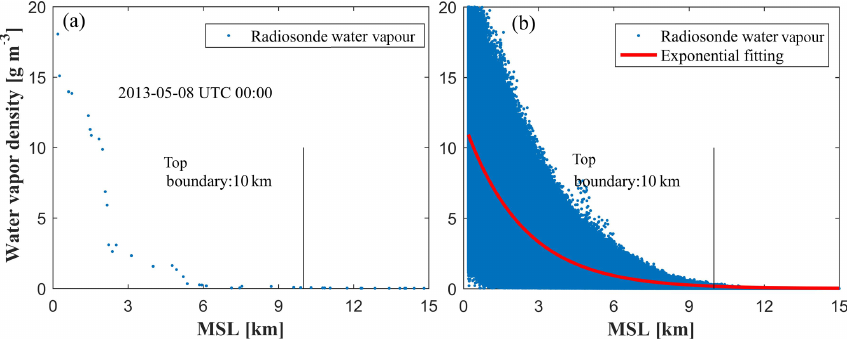
Figure 5. The vertical distribution of water vapour density in a single sounding event (a) and the 3-D water vapour distribution of the tomography area and exponential fitting curve from 2000 to 2015 (b) .